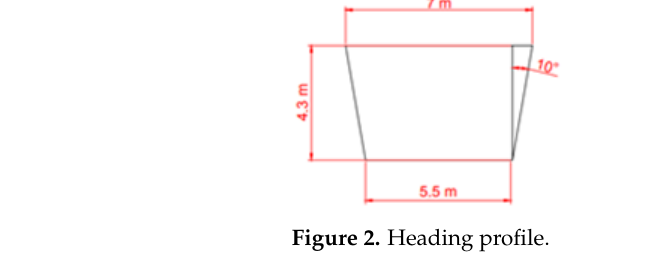
Figure 2. Heading profile.